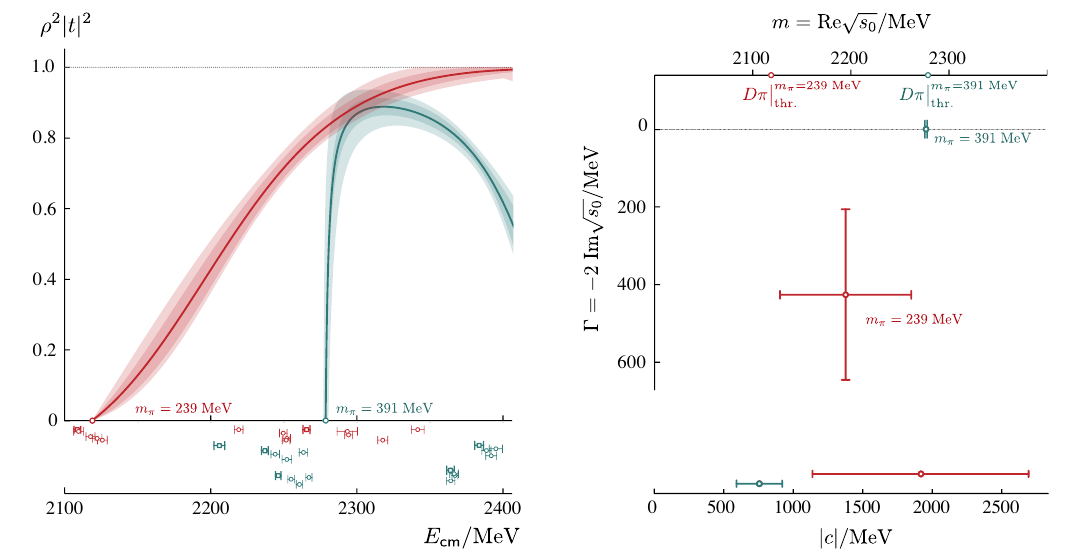
Figure 10. The left panel shows the reference S -wave scattering amplitude at m π = 239 MeV (red) and 391 MeV (blue) plotted as ρ 2 | t | 2 with the energies that were used to constrain them shown below. The bold square points are from [000] A + , the other points are from moving frame 1 irreps. The inner bands show the statistical uncertainty from the χ 2 minimisation. The outer band for m π = 239 MeV includes variation over mass, anisotropy and parameterisations. The outer band for m π = 391 MeV includes variation over only mass and anisotropy; ref. [26] found only a small effect from varying the parameterisation for this elastic system with a near-threshold bound state. The upper right panel shows the S -wave pole positions including the additional uncertainty found from the variation over parameterisation, which is significant for m π = 239 MeV. The pole at the lower pion mass is a resonance found on the unphysical sheet, and at the higher pion mass is a bound state found on the physical sheet. The lower right panel shows the magnitudes of pole couplings to the S -wave Dπ